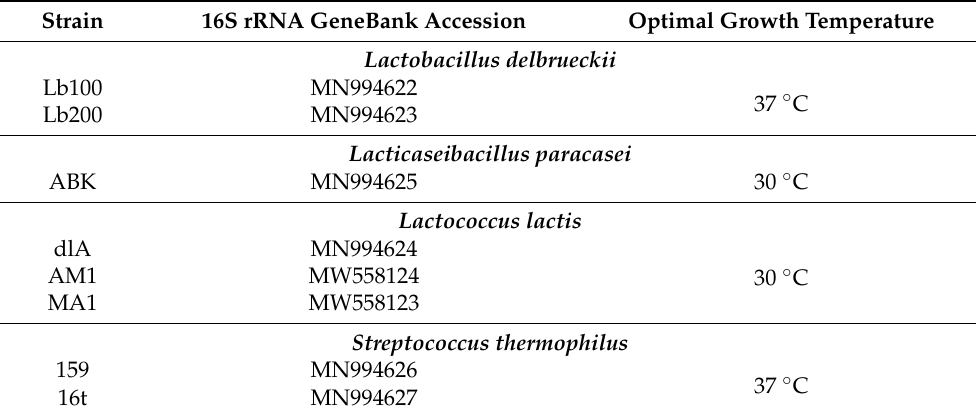
Table 1. Strains of lactic acid bacteria that were used in this